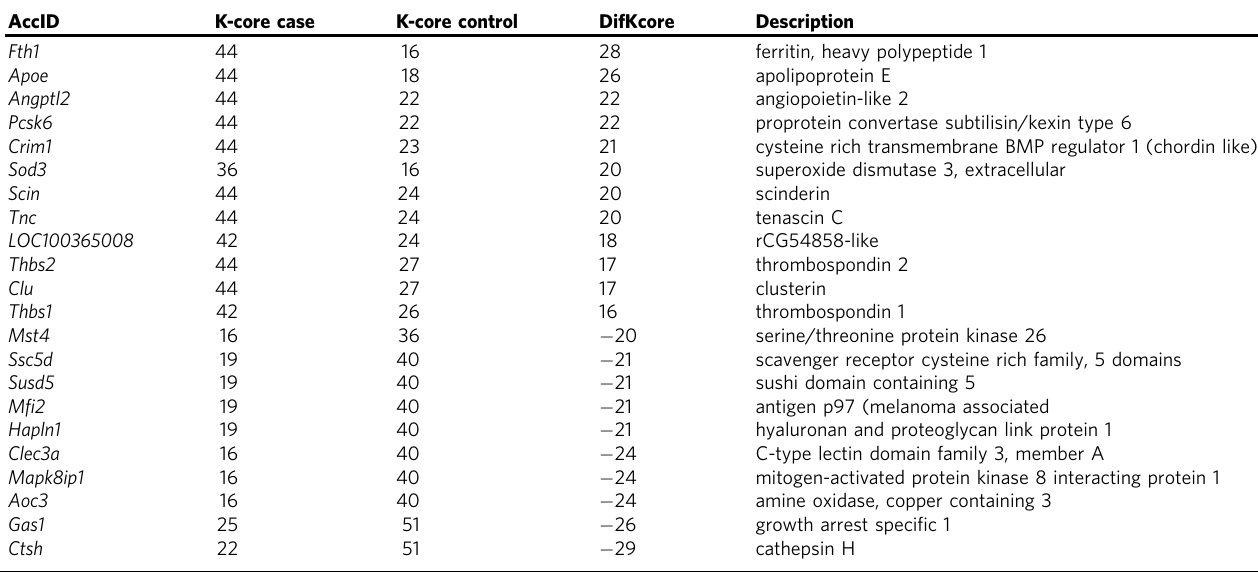
Table 1 Differentially expressed genes ranked in front